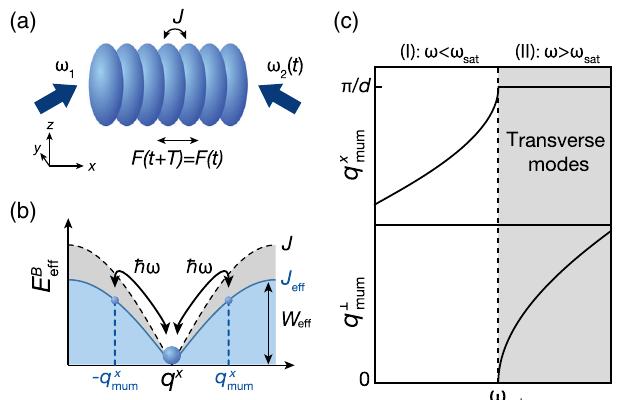
FIG. 1. Illustrations of the experimental setup and the proper- ties of parametric instabilities. (a) Schematic of the driven 1D optical lattice with tunneling J , generated by two laser beams with frequencies ω 1 , and weak harmonic transverse confine- ; 2 ment. Modulating ω 2 ð t Þ periodically with frequency ω generates a force F ð t Þ with period T ¼ 2 π = ω . (b) Illustration of the ð q x ; J Þ , with width effective 1D Bogoliubov dispersion E B eff eff W reduced according to the Floquet-renormalized tunnel eff coupling J (blue) compared to the static lattice case (gray). eff ¼ ℏ ω induced by the modulation Parametric resonances at E B eff lead to instabilities centered around the most unstable mode q x ; ℏ ¼ h= ð 2 π Þ is the reduced Planck ’ s constant. (c) Momen- mum ¼ ð q x Þ , as ; q ⊥ tum of the most unstable mode, q mum mum mum predicted by Bogoliubov theory, which shows a clear separation between lattice (I) and transverse (II) degrees of freedom (d.o.f.), ≈ W that occurs at the saturation frequency ℏ ω ; d is the sat eff lattice